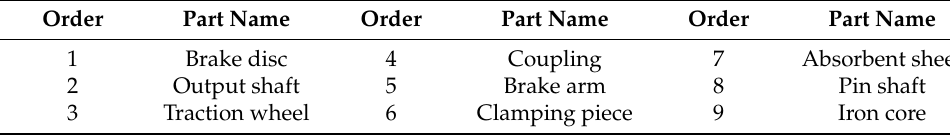
Table 3. Processing parts information.